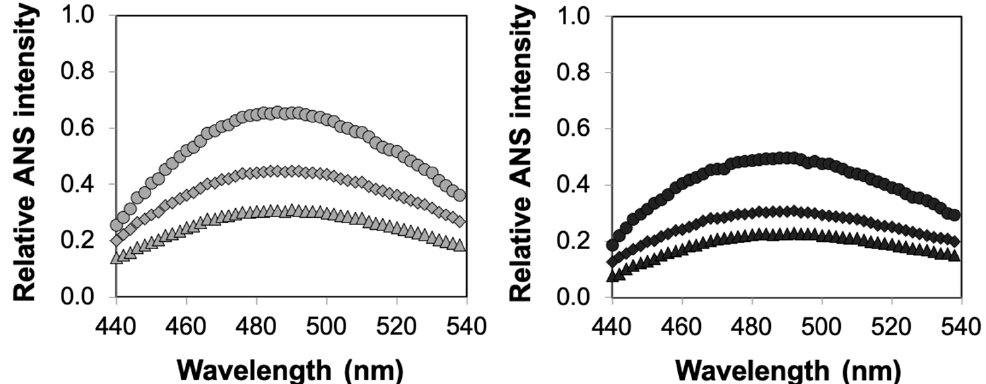
Figure 6. Structural stability of HRP encapsulated in agarose–dextran hybrid gels. Relative ANS fluorescence intensities for HRP encapsulated in agarose (circles) and agarose incorporating 100 mg / mL (diamonds) and 200 mg / mL (triangles) dextran at 60 ◦ C—0.5% agarose (left, gray markers) and 2% agarose (right, black markers). Relative fluorescence intensities for the agarose–dextran HRP formulations are reported after subtraction of the spectra of the corresponding agarose–dextran gels containing no enzyme. Each data point represents an average of triplicate measurements, with standard error <15%.